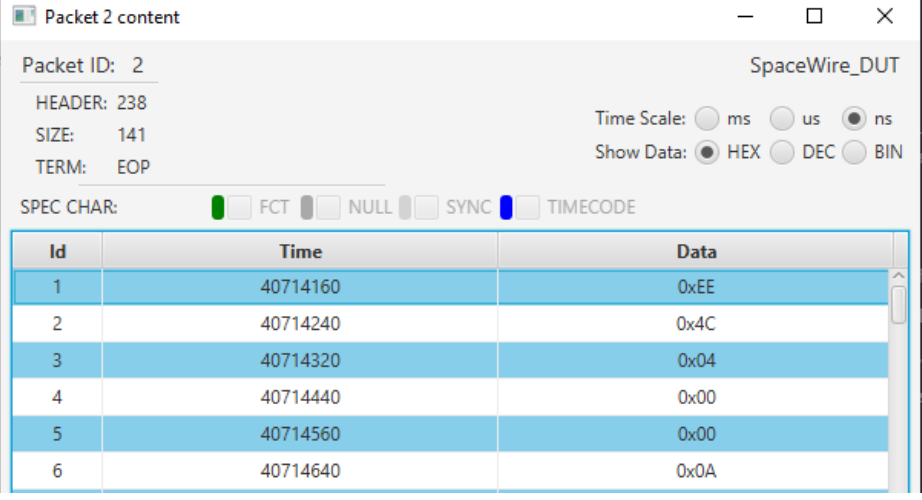
Figure 6. SpaceART Sniffer GUI partial visualization of the content of the second SpW packet transmitted by the SpaceWire